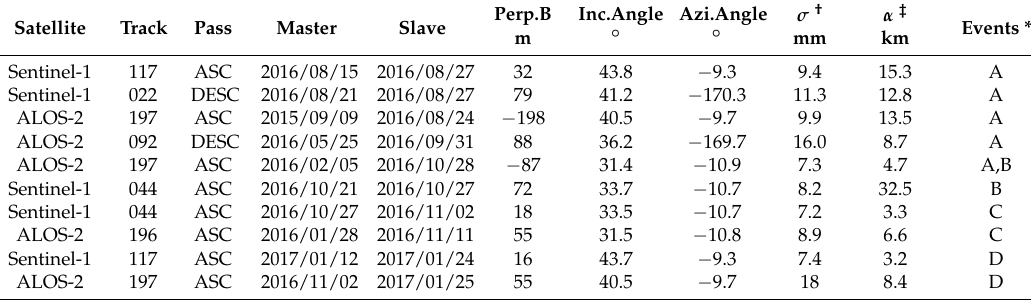
Table 2. Details of satellite synthetic aperture radar (SAR) images used in this